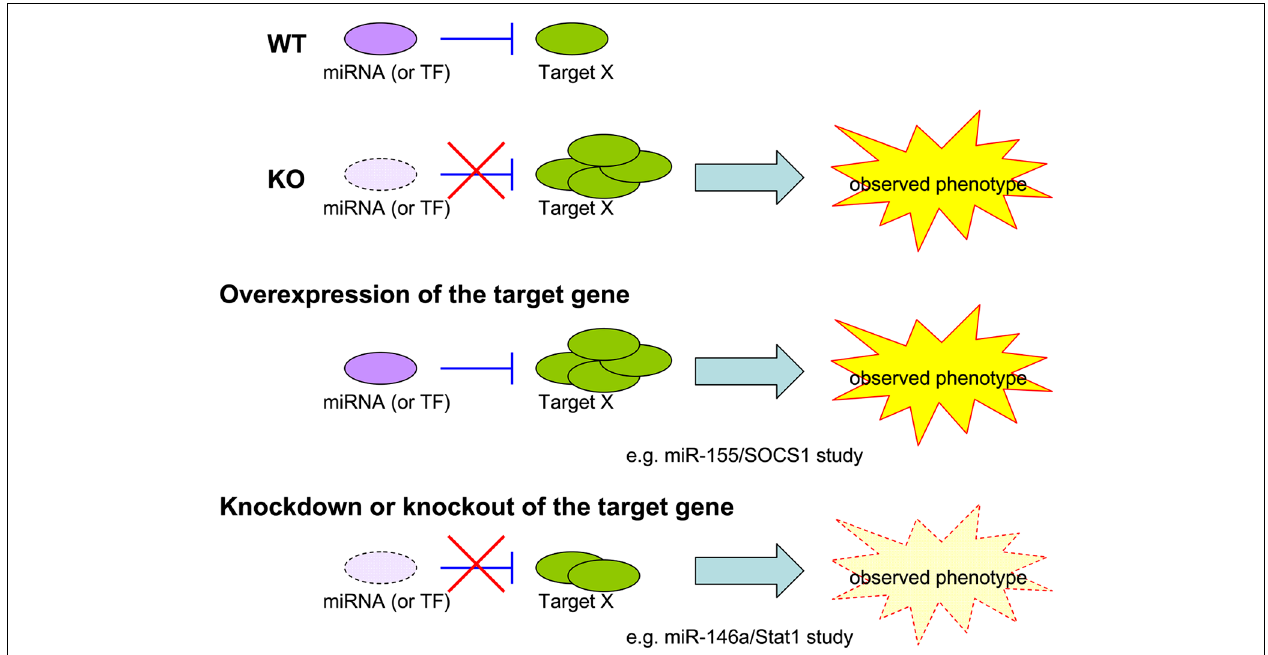
FIGURE 1 | Models for miRNA study. Current experimental approaches to validate the biological significance of a single target repressed by a given miRNA in an observed